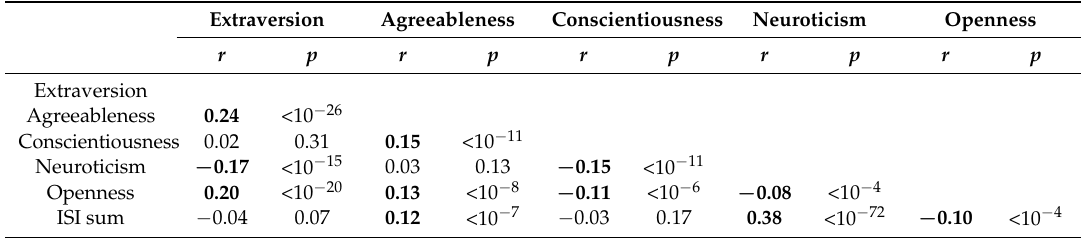
Table 2. Pearson correlation coefficients and corresponding p -values for the correlations among the five personality traits and between the five personality traits and the Insomnia Severity Index sum score.